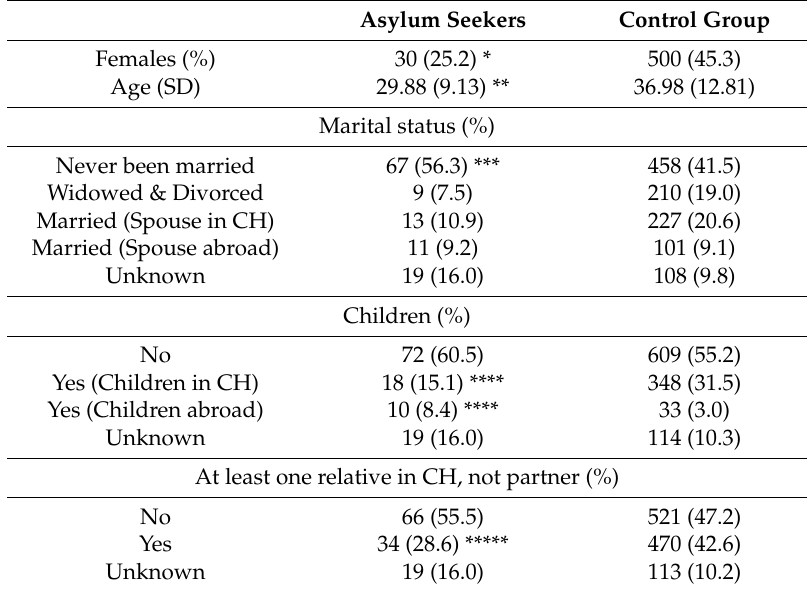
Table 1. Sociodemographic characteristics of asylum seekers ( n = 119) and control group ( n =